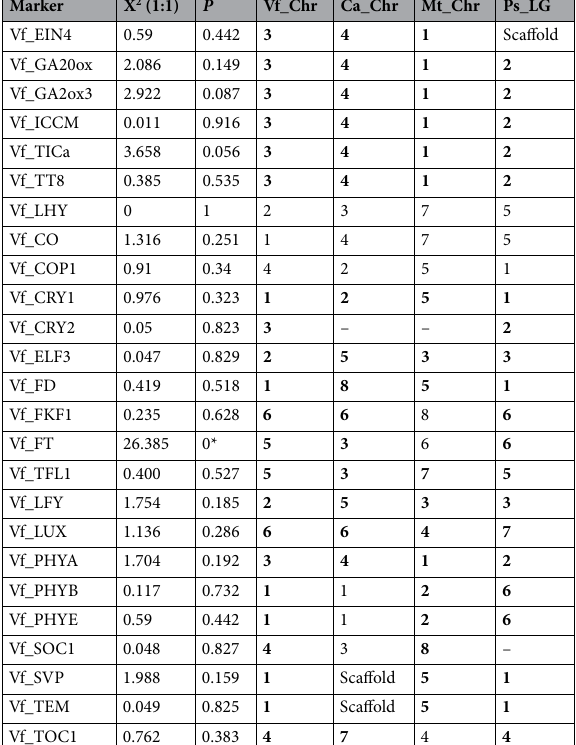
maps 34,38 allowed us to assign all the LGs to the corresponding faba bean chromosomes (chr.). All candidate- gene markers were included in the new genetic map, with numbers ranging from one in LGVI to six in LGI and LGIII. We next checked whether the marker genes share syntenic positions in V. faba and the closely related species M. truncatula , P. sativum and C. arietinum (Table 3). The level of synteny was quite high (69%), with 18 out of 25 gene markers conserved in at least one other species. Twelve V. faba genes were syntenic with C. arietinum , 15 with M. truncatula and 16 with P. sativum . Finally, 12 markers (Vf_GA20ox, Vf_GA2ox3, Vf_ICCM0293,